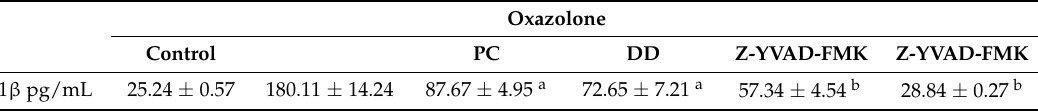
Table 2. ELISA analysis showing oxazolone-induced increase in IL-1 β production in the absence and presence of Z-YVAD-FMK in HaCaT cells. P. cicadae and D. dasycarpus abolished oxazolone–induced increase in IL-1 β